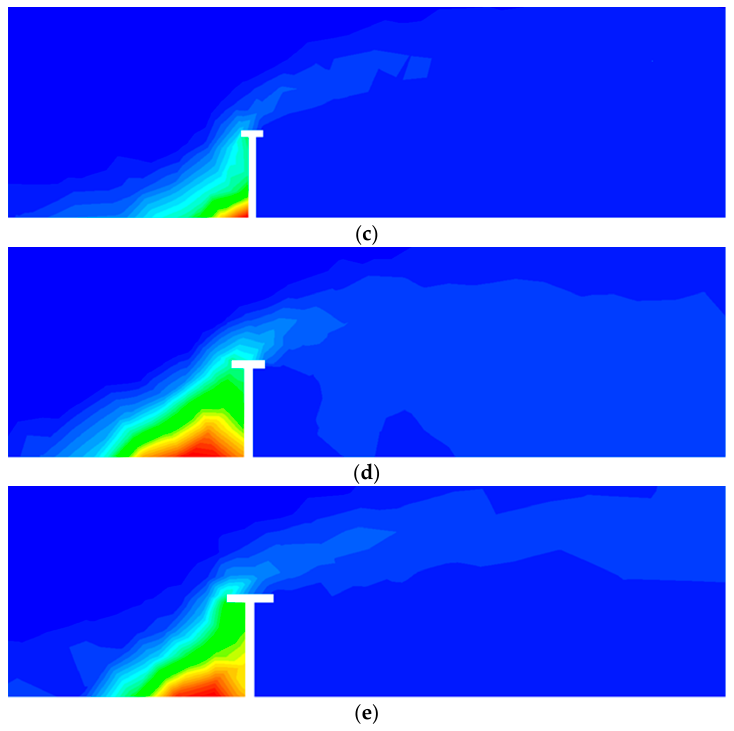
Figure 18. Contours of CO molar concentration for different barrier shapes (H = 6 m). ( a ) Base case; ( b ) case 1; ( c ) case 2; ( d ) case 3; ( e ) case 4.